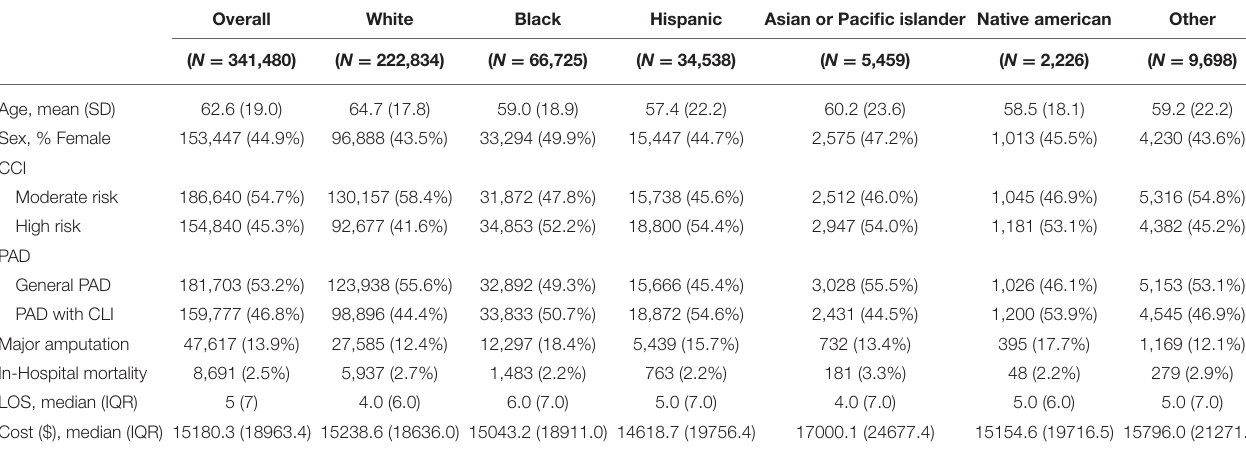
TABLE 1 | Demographic and Hospitalization Measures by race-ethnicity group. Overall White Black Hispanic Asian or Pacific islander Native american